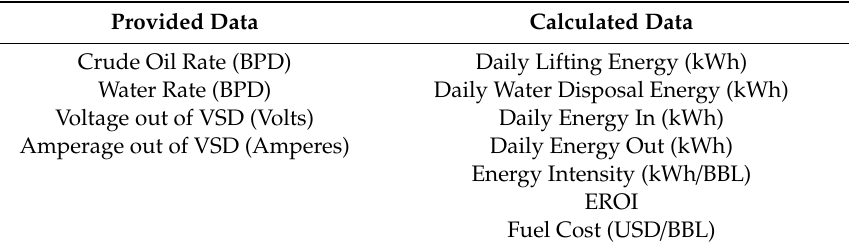
Table 2. Provided and derived ESP data per